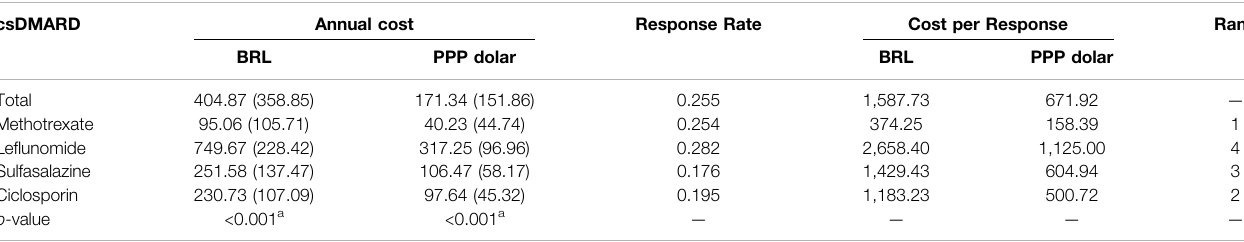
TABLE 6 | Drug costs and cost per response of